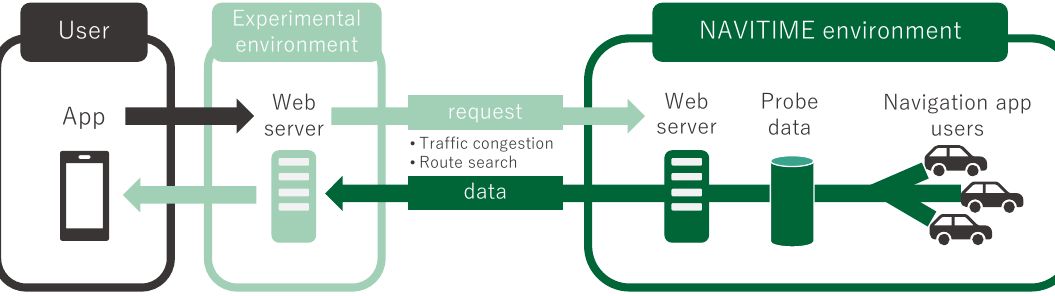
Figure 3. Overview of the application architecture using NAVITIME Application Programming Interfaces (APIs).